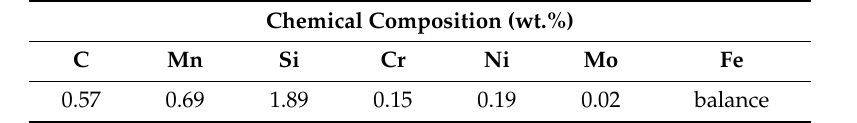
Table 1. Chemical composition of investigated 55Si7 steel-glow discharge spectrometer GDS500A (Leco Corporation, Saint Joseph, MO, USA).